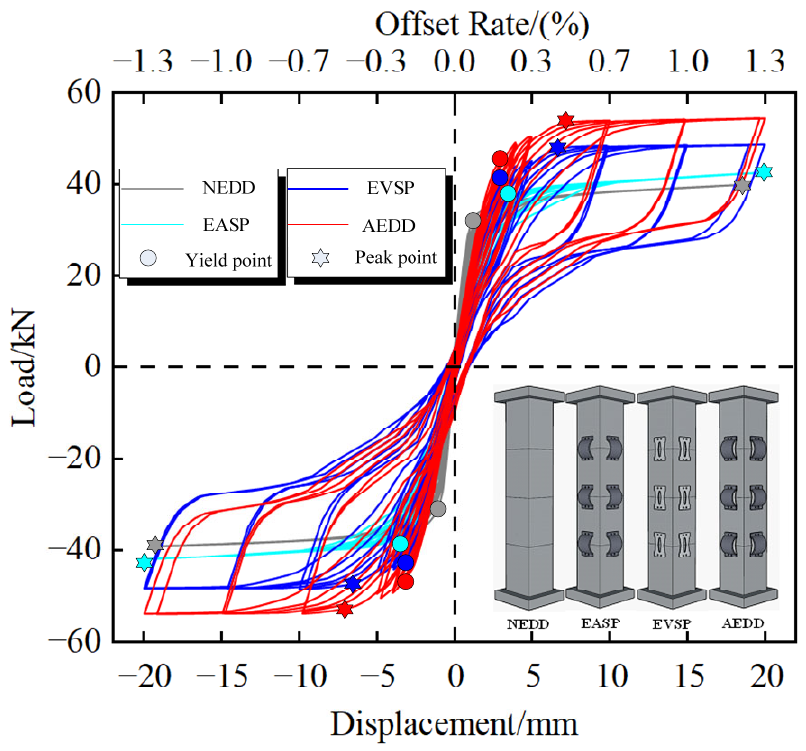
Figure 13. Hysteretic curves of different piers.